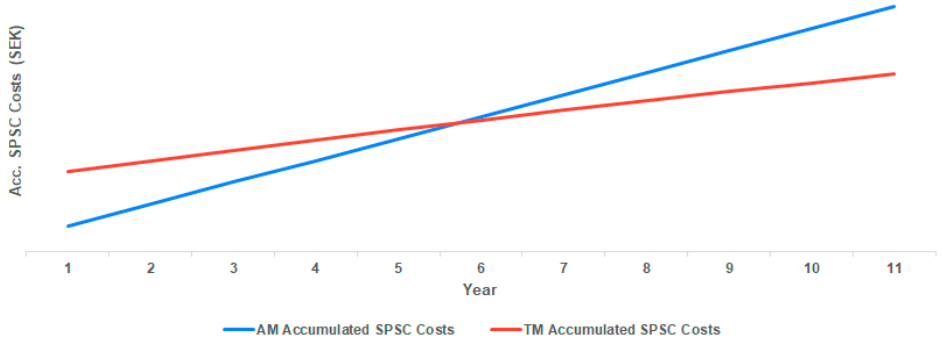
Figure 4. AM and TM accumulated SPSC costs for P3 over the eleven-year planning horizon.